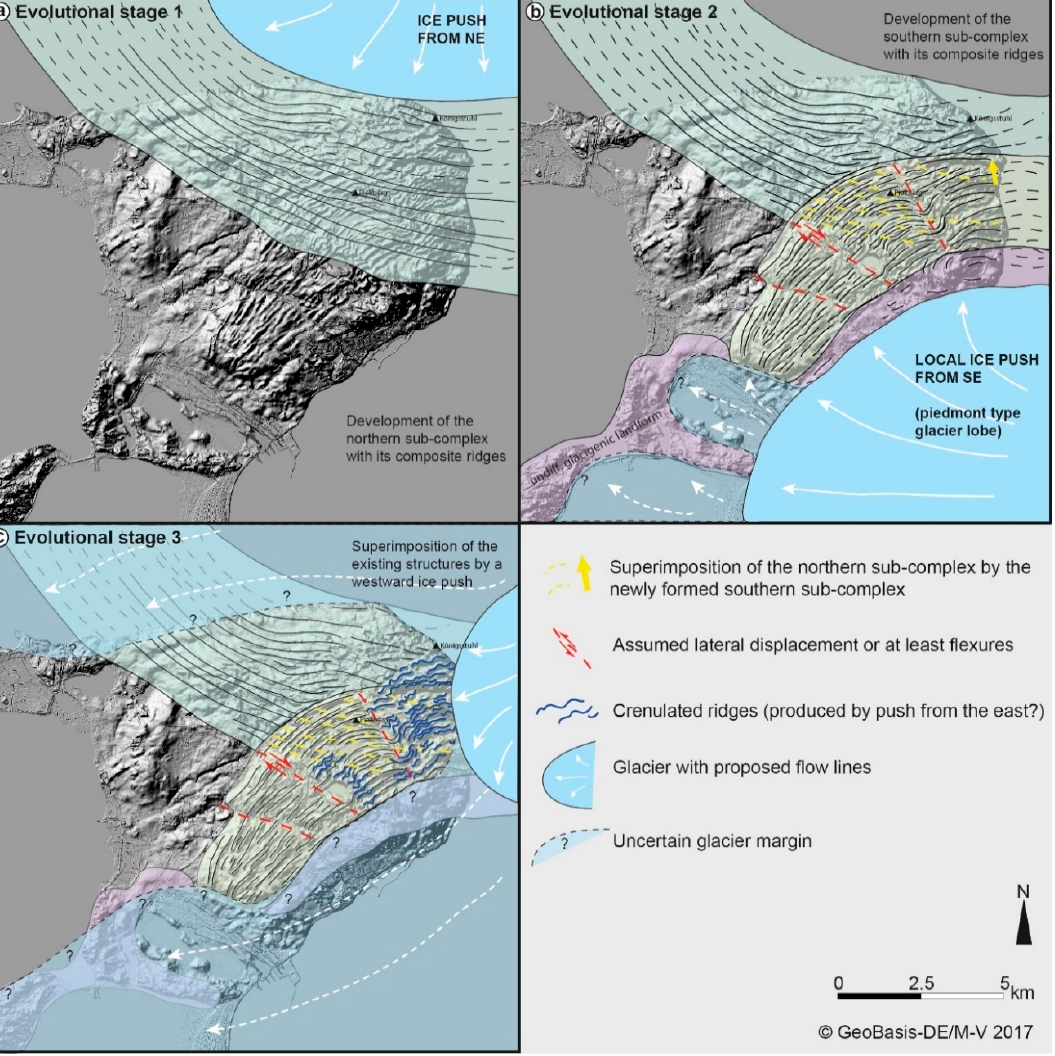
Figure 12. Multi-stage evolutional model of the composite ridges on top of the Jasmund Glacitectonic Complex. ( a ) Formation of the northern sub-complex by a local ice push from NE; ( b ) Development of the southern sub-complex by a local ice push from SE leading to a partly truncation and superimposition of the northern ridge set; ( c ) Minimum reconstruction of the ice front only touching the easternmost part of the glacitectonic complex (light blue) and assumed wider glacier extent, which kind of envelopes the complex (transparent light blue). The local ice push from the E/ENE reshapes the quasi-straight ridges to wavy forms.